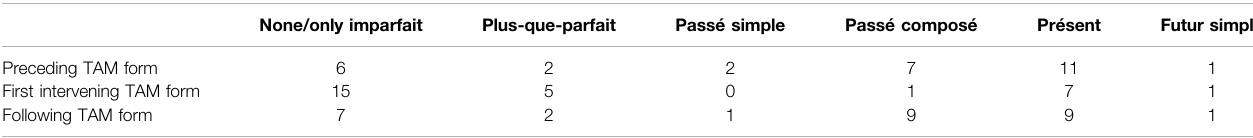
TABLE 7 | TAM forms related to the imparfait chains in Sketch Engine (for a total of 29 texts). None/only